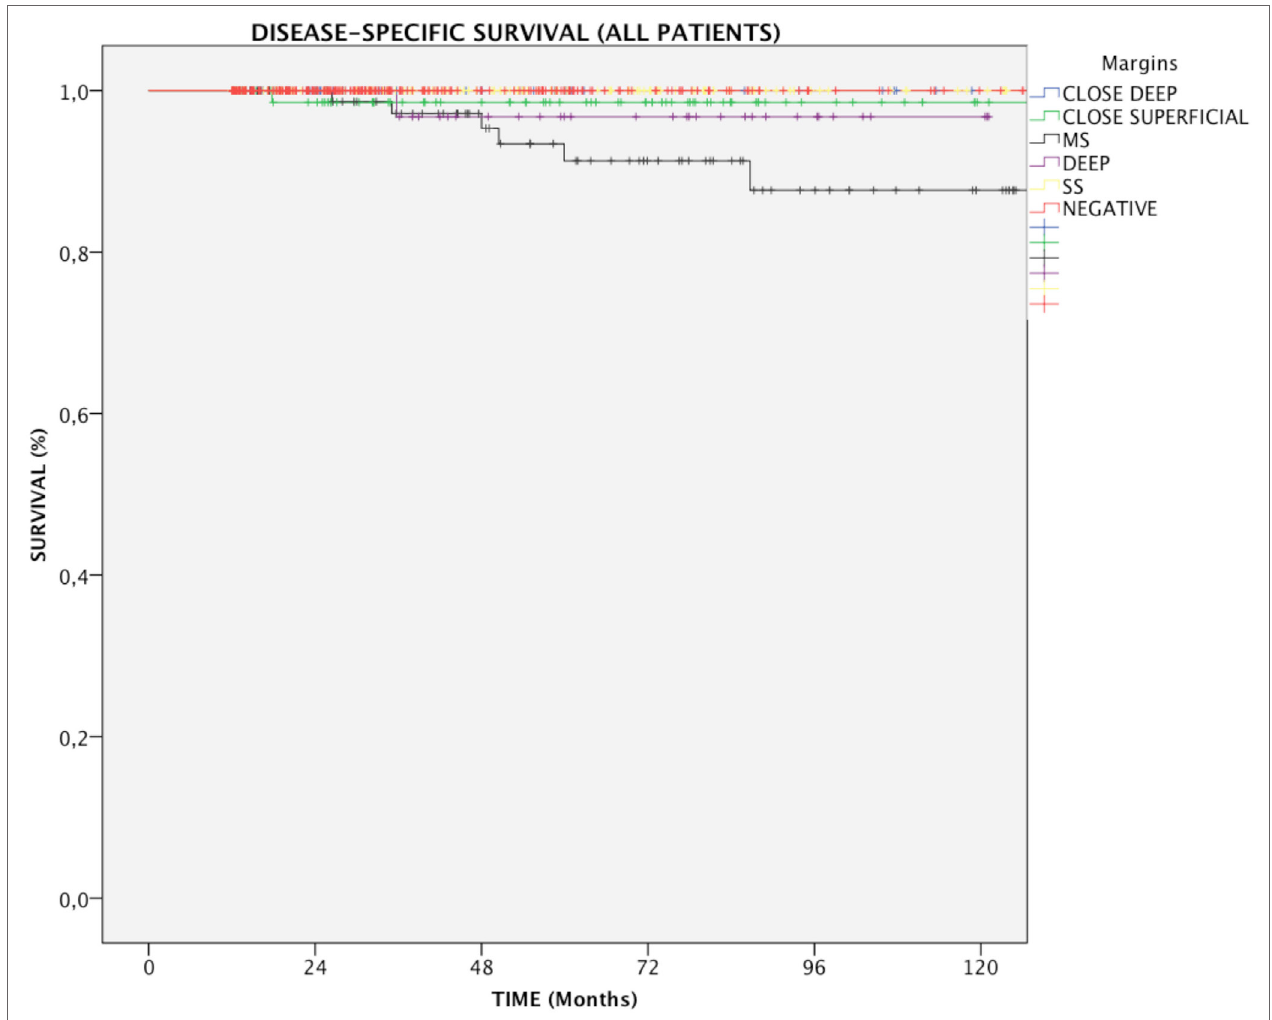
FigUre 1 | Kaplan–Meier curves for the entire patients cohort showing disease-specific survival in relation to margin status. MS, positive multiple superficial margins; SS, positive single superficial margin; “ + ” symbol, censored